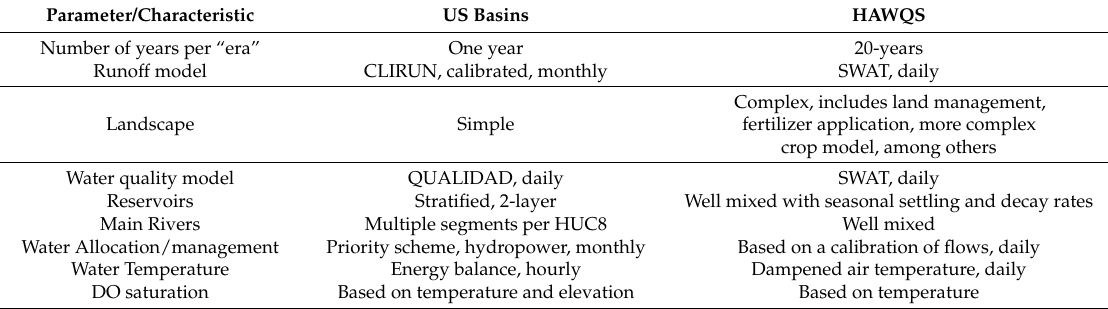
Table 1. SummaryofkeydifferencesbetweenUSBasinsandHydrologicandWaterQualitySystem(HAWQS).